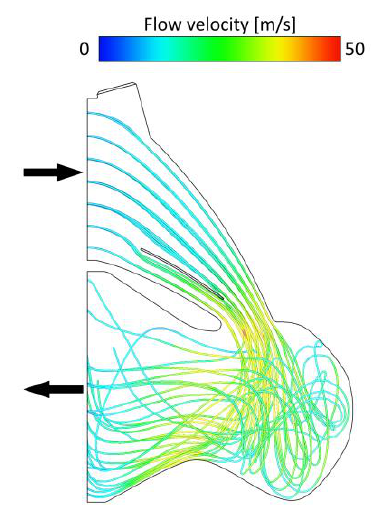
Fig. 10. Velocity streamlines inside the middle cone at a gas mass flow rate of 300 kg/h